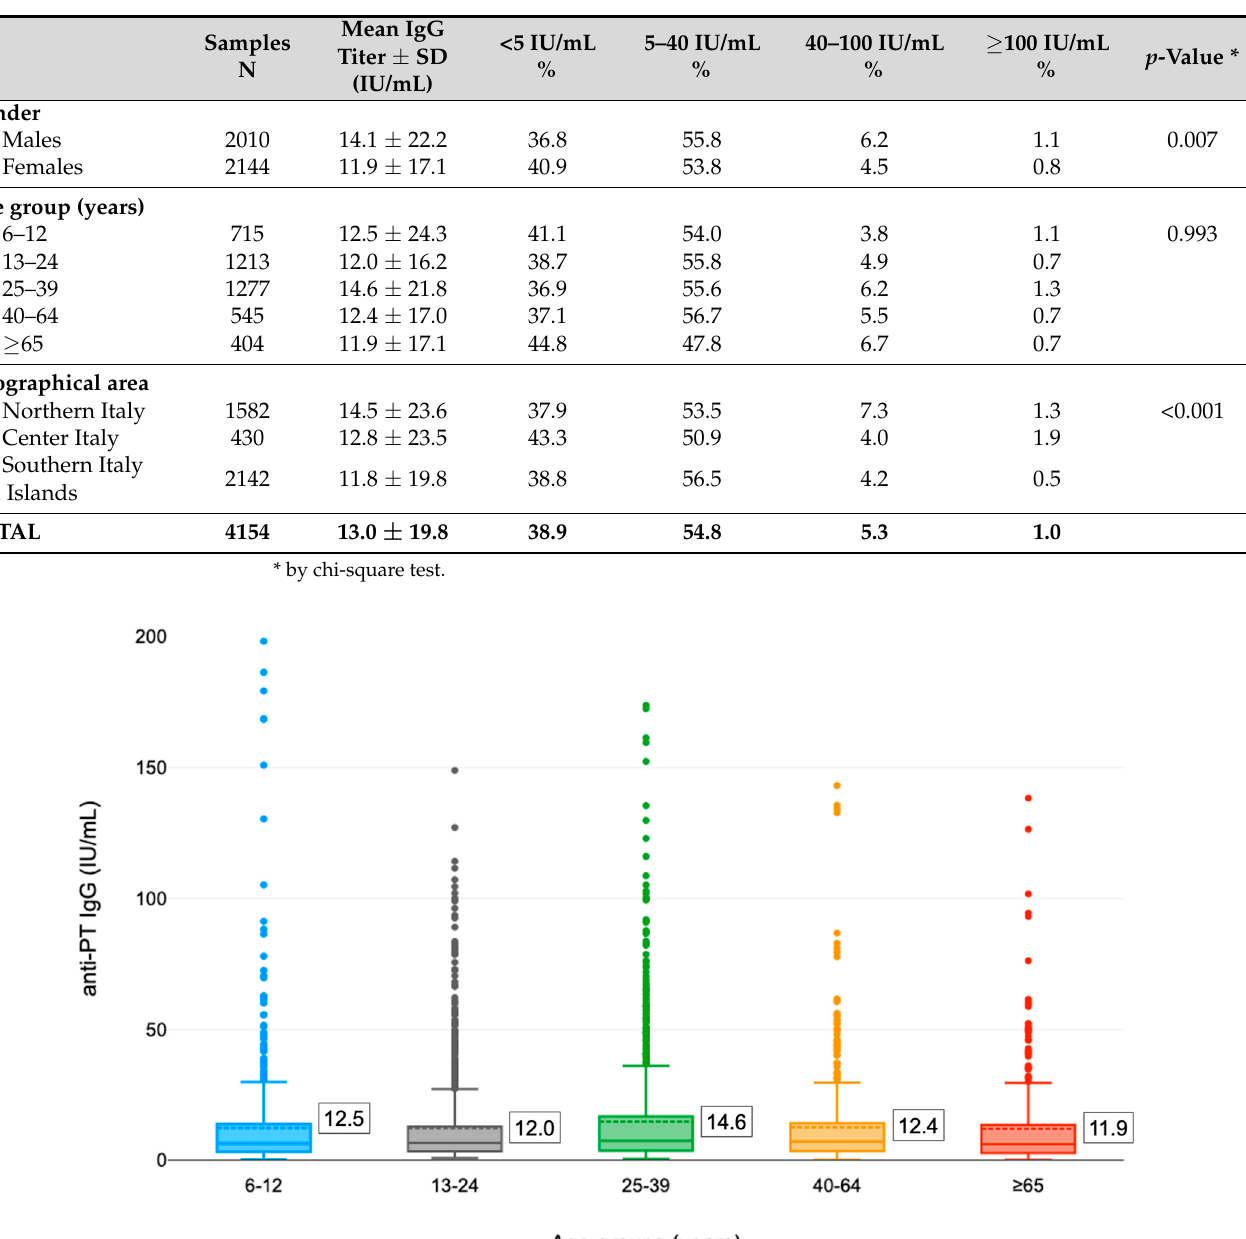
Table 1. Results of the serological investigations carried out on 4154 subjects stratified by gender, age group and geographical area.